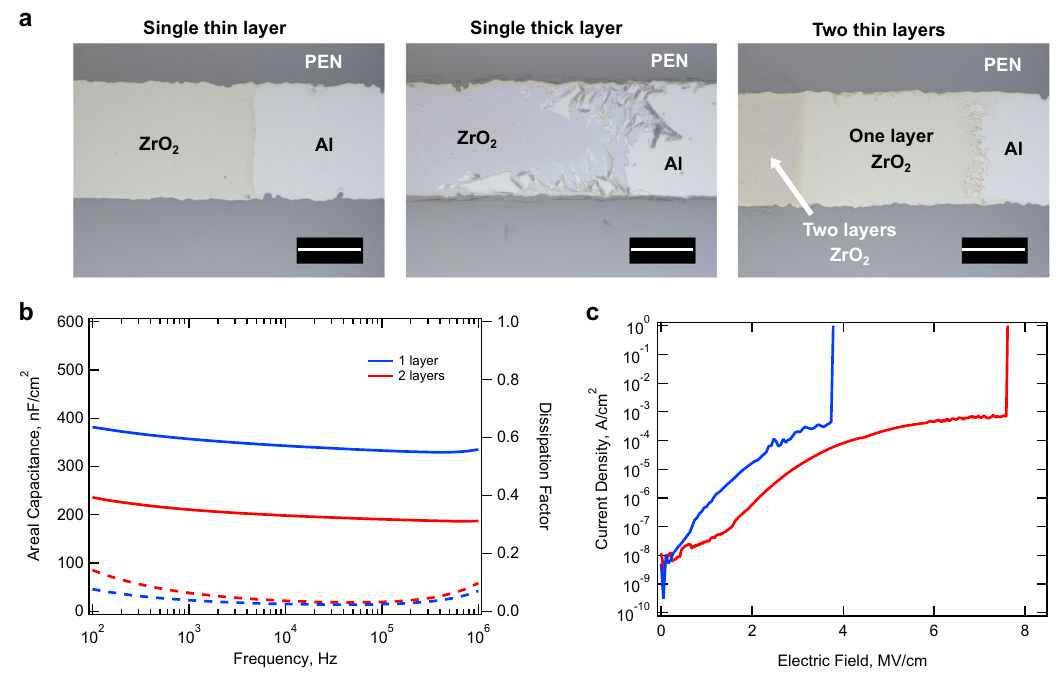
Fig. 3 Different thickness of ZrO 2 dielectric fi lms. a Optical images of a single thin layer of sm-PC ZrO 2 on a patterned bottom Al contact on PEN showing a smooth fi lm and good adhesion to Al (left), a single thick sm-PC ZrO 2 layer showing poor adhesion between the oxide and substrate (middle), and two thin sm-PC ZrO 2 layers with good adhesion and a smooth surface (right). The two areas in the right image are due to misalignment of masks in the two-step process. Scale bars represent 50 µm. b Areal capacitance (left axis, solid lines) and dissipation factor (right axis, dashed lines) for a single-layer (blue) and two-layer (red) ZrO 2 capacitor. c Leakage current density versus applied electric fi eld for the single-layer (blue) and two-layer (red) ZrO 2 capacitors. All fi lms are processed using 20 pulses at 5.23 J/cm 2 per pulse, 20 ms pulse length, 0.2 Hz for each